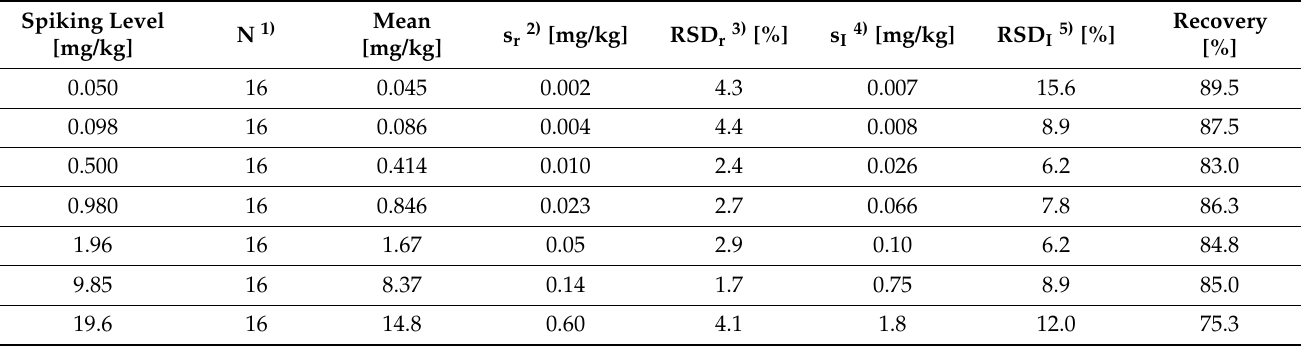
Table 2. Recoveries, repeatability, and intermediate precision obtained by DHS-VTT-GC-MS analysis of PDCB in beeswax using external quantitation.